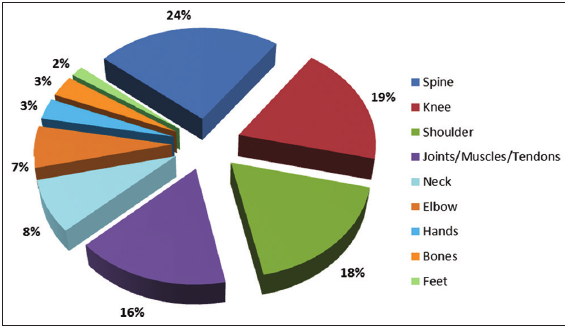
FIGURE 3. Distribution of articles per pain location treated with CRet and